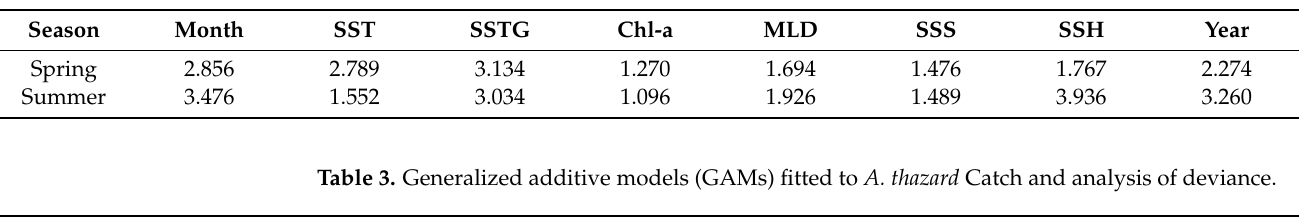
Table 2. Collinearity diagnostics tests of environmental variables.